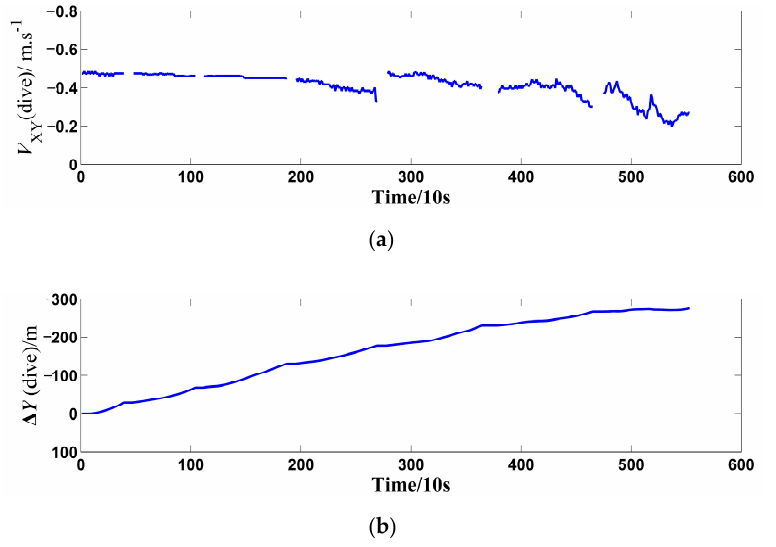
Figure 17. Identification results of Petrel-L in dive motion: ( a ) horizontal velocity and ( b ) trajectory error.